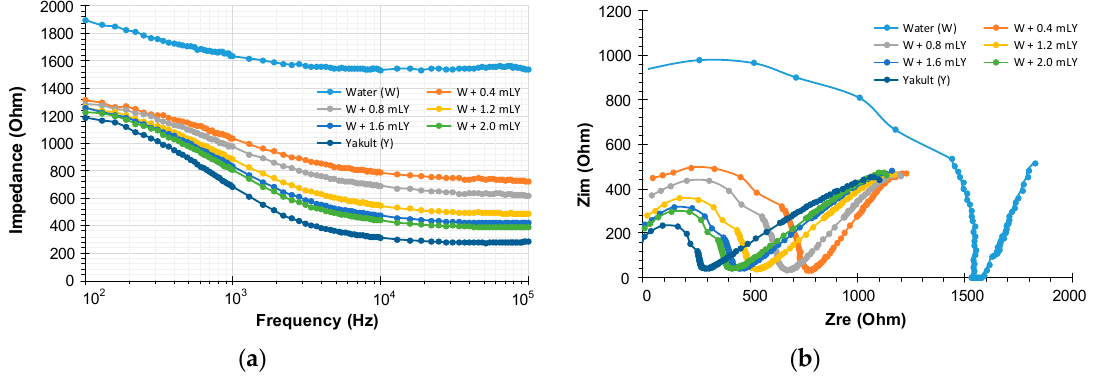
Figure 9. Impedance values of Yakult solution: ( a ) in Bode plot, and ( b ) in Nyquist plot .